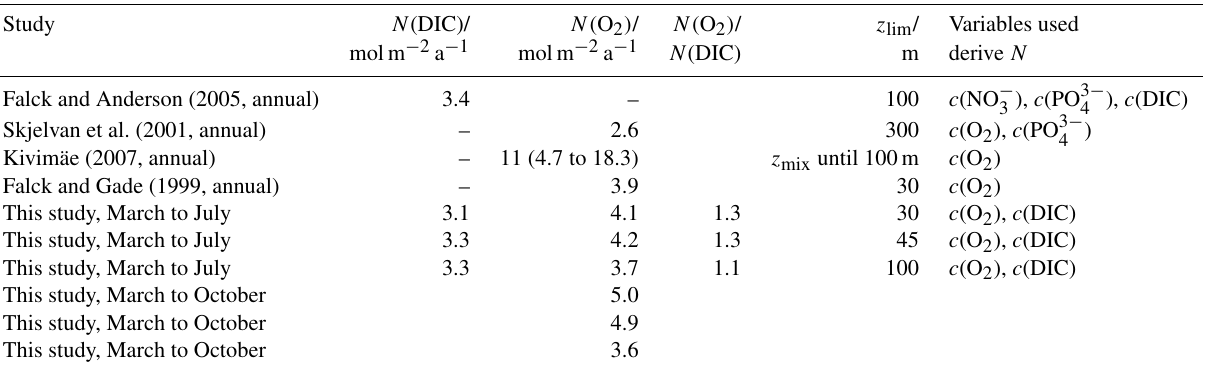
Table 3. Net community production ( N ) estimates in the Norwegian Sea (with integration depth z lim ). Falck and Anderson (2005) used year-round data from 1960 to 2000 between 62 and 70 ◦ N and from 1991 to 1994 at OWSM. Skjelvan et al. (2001) used year-round data from 1957 to 1970 and from 1991 to 1998 between 67.5 ◦ N, 9 ◦ E, and 71.5 ◦ N, 1 ◦ E, and along 74.5 ◦ N from 7 to 15 ◦ E. Kivimäe (2007) used year-round data from 1955 to 2005, and Falck and Gade (1999) used year-round data from 1955 to 1988 in all of the Norwegian Sea. While the previous studies report annual N estimates, the present study derives N (O 2 ) between March and October and N (DIC) between March and